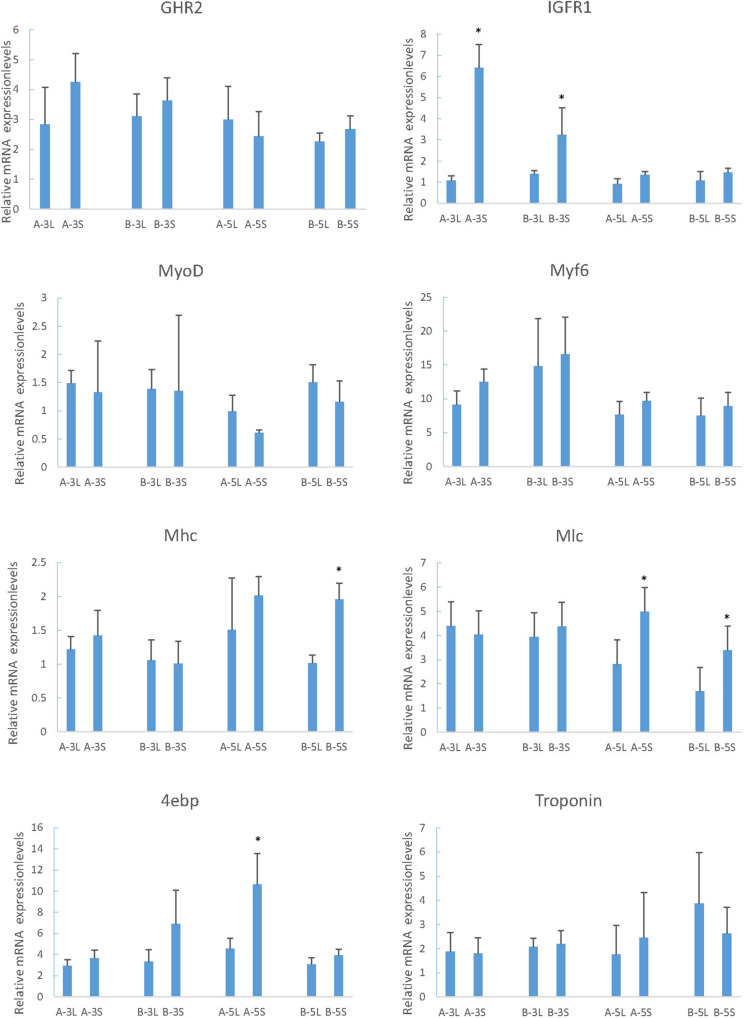
Relative expression of growth-related genes in mandarin fish with different growth traits. 18S was used as a housekeeping gene. All data are represented as the mean ± SEM (n = 6). * Indicates a significant (p < 0.05) difference between overweight and underweight. A-3L, large fish of 3-month old from A family; A-3S, small fish of 3 months from A family; B-3L, large fish of 3-month old from B family; B-3S, small fish of 3-month old from B family; A-5L, large fish of 5- month old from A family; A-5S, small fish of 5-month old from A family; B-5L, Large fish of 5-month old from B family; B-5S, small fish of 5-month old from B family.